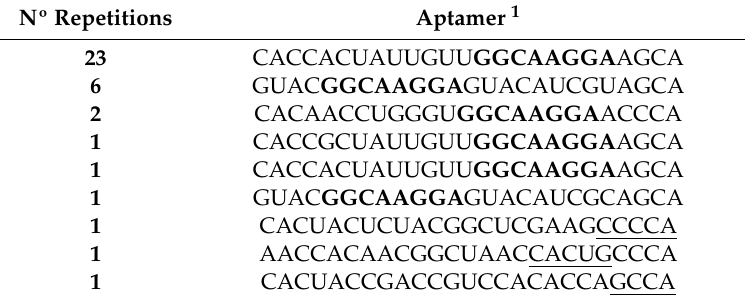
Figure 4. Representation of the HIV-1 particle. The secondary structure model of the genomic RNA fragment used as the aptamers’ target in the selection procedure is outlined on the right, depicting the well characterized functional structural elements. The genomic organization of these structural elements is indicated at the bottom. The polyA domain is indicated in green. The designed RNApt16 aptamer targeting the apical loop of the polyA element is represented in red. Table 1. Selected antiHIV-1 aptamers after 14 rounds of selection.